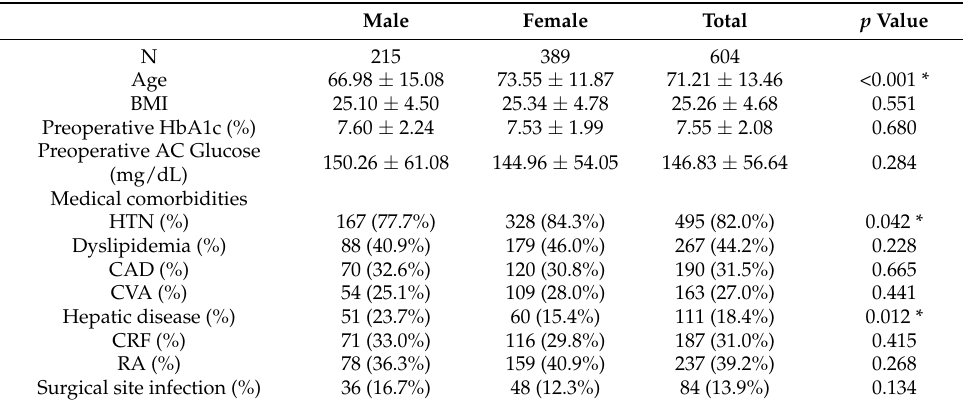
Table 1. Demographics of the T2DM patients ( n = 604).